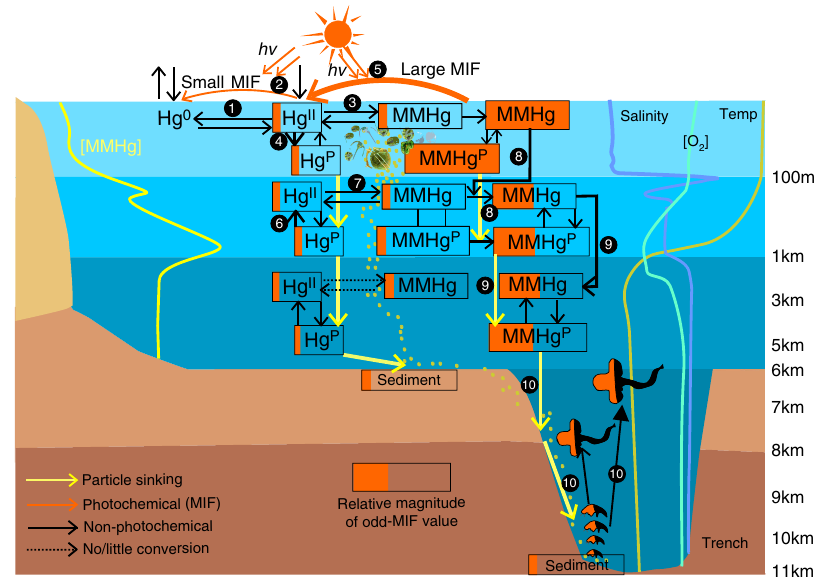
Fig. 5 Conceptual illustration of mercury cycling in trench systems. Atmospheric inorganic Hg II (IHg(II)) is deposited to the epipelagic waters where it is microbially (1) or photochemically (2) reduced to Hg(0), microbially methylated to monomethylmercury (MMHg) (3), and scavenged as Hg P by sinking particles (4). Photo-reduction of IHg(II) results in residual IHg(II) with small odd-MIF (2), while photodegradation of MMHg results in residual MMHg with large odd-MIF (5). The sinking particles are decomposed and release IHg(II) in the mesopelagic waters (6) where microbial methylation produces MMHg that inherits the small odd-MIF of IHg(II) (7). The mixing of MMHg produced in epipelagic and mesopelagic waters in the intermediate ocean (8) results in MMHg with moderate odd-MIF 16 , which is then transported to the deep ocean by sinking particles (9). Since no/little MMHg is produced in the deep ocean, the MMHg with moderate odd-MIF is incorporated into deep food webs (10). Also shown are typical depth pro fi les of NPO dissolved MMHg concentrations 10,12 , Mariana dissolved oxygen [O 2 ] 59 , and Mariana seawater salinity and temperature measured in this study. The hadal food web is based on Gerringer 37